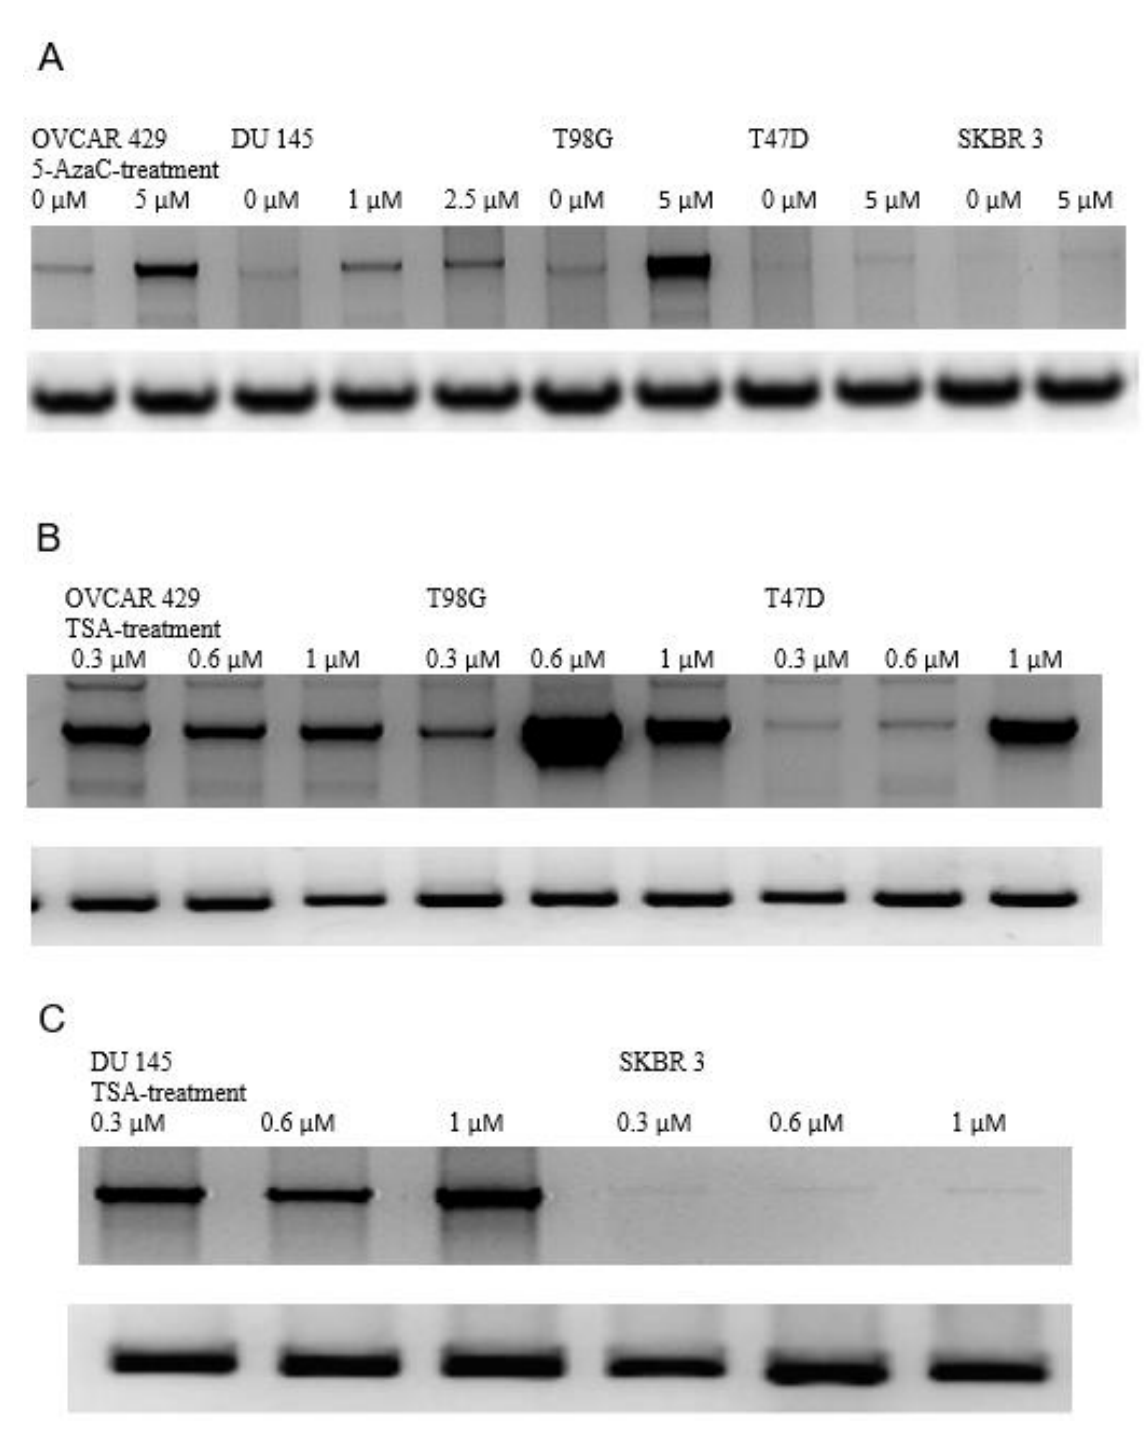
Figure 4. GluR6 expression in the presence of 5-azacytidine and TSA. ( A ) The cell lines were treated with 5-azacytidine, and the GluR6 transcript was amplified by RT-PCR. The cell lines and the treatment are indicated. ( B , C ) The cells were treated with TSA and the transcripts amplified by RT-PCR. The cell lines and the treatment are indicated. Amplification of GAPDH transcript to indicate comparable amounts of cDNA used for amplifying the transcript corresponding to GluR6 are shown in the bottom strip of each panel. The top portion of the panel shows amplification of GluR6 transcript. The amplified transcripts corresponding to GluR6 and GAPDH were electrophoresed in separate gels.